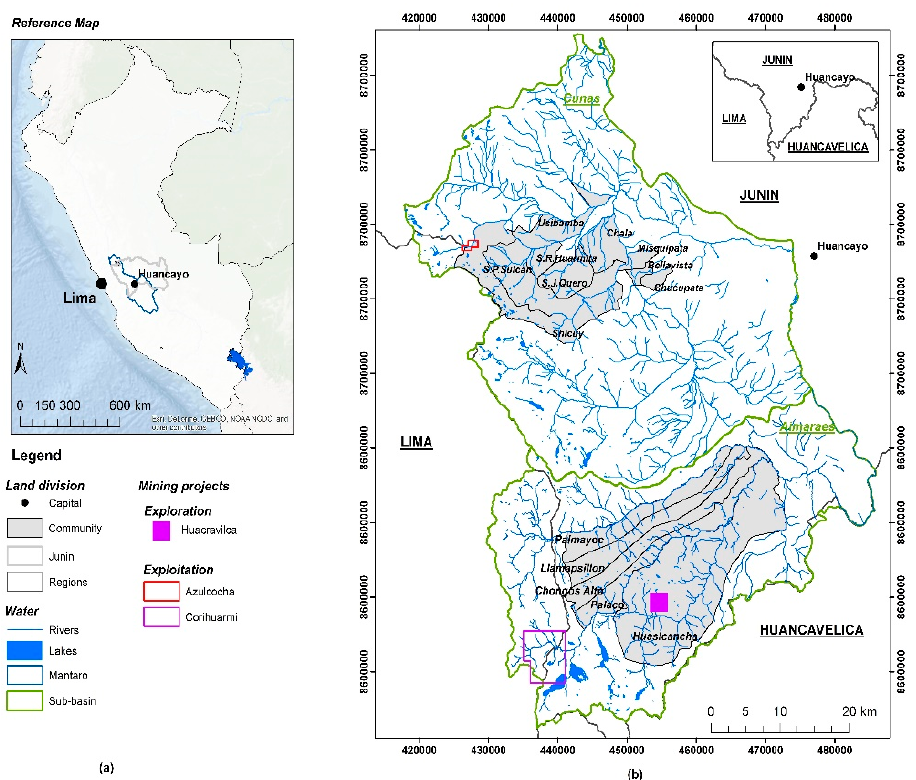
Figure 2. Research area in ( a ) Junin region and ( b ) location of mining operations and campesino communities in Aimaraes and Cunas sub-basins (based on governmental data and INGEMMET [73]).